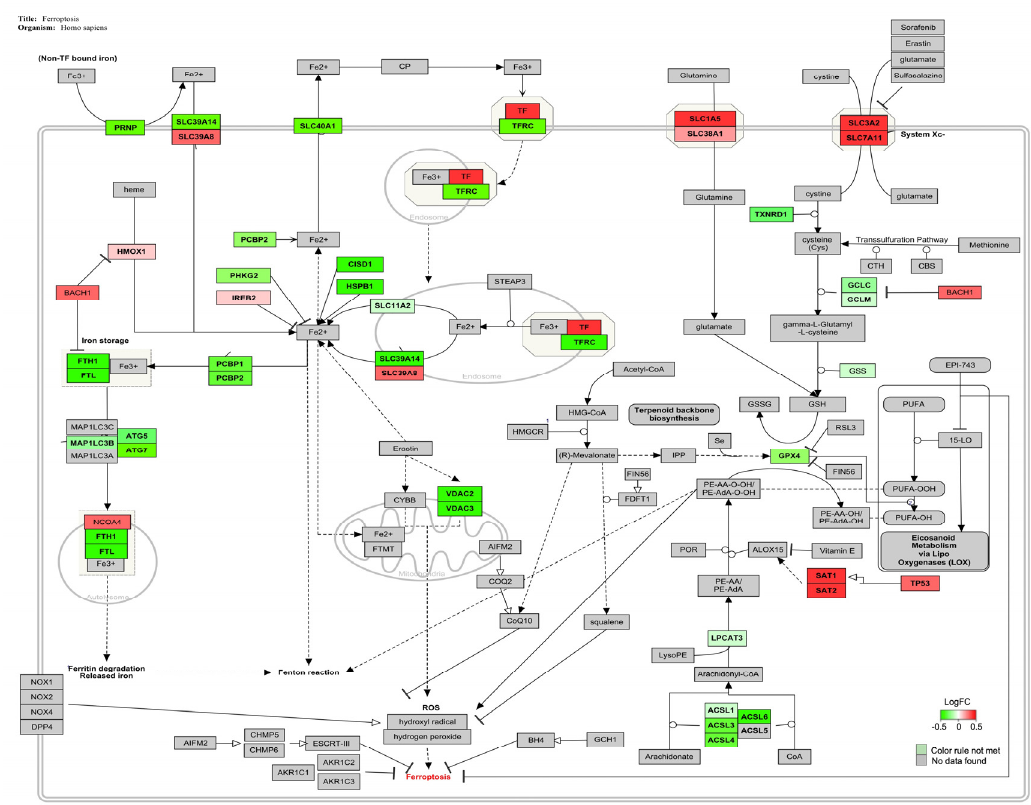
Figure 4. Genes involved in ferroptosis pathway for Homo sapiens are represented in red and green. The up-regulated genes are represented in red and the down-regulated ones following AFB1-OTA exposure (100 nM for both toxins) are represented in green.